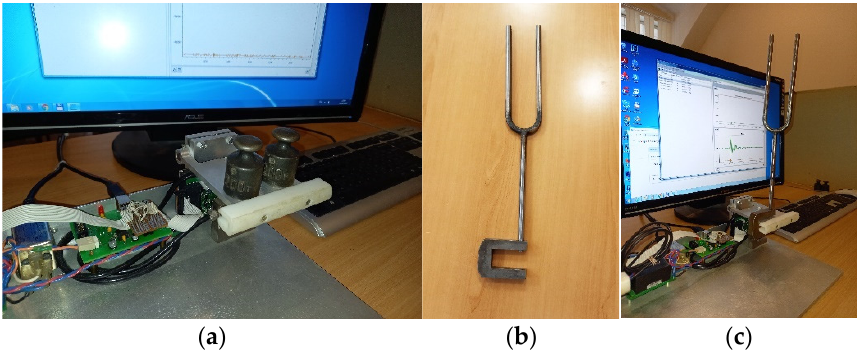
Figure 7. Testing of the strain gauge measuring system: ( a ) checking the measurement of the constant component of the sensor signal using a set of weights; ( b ) tuning fork; ( c ) checking the measurement of the frequency component of the sensor signal using a tuning fork.